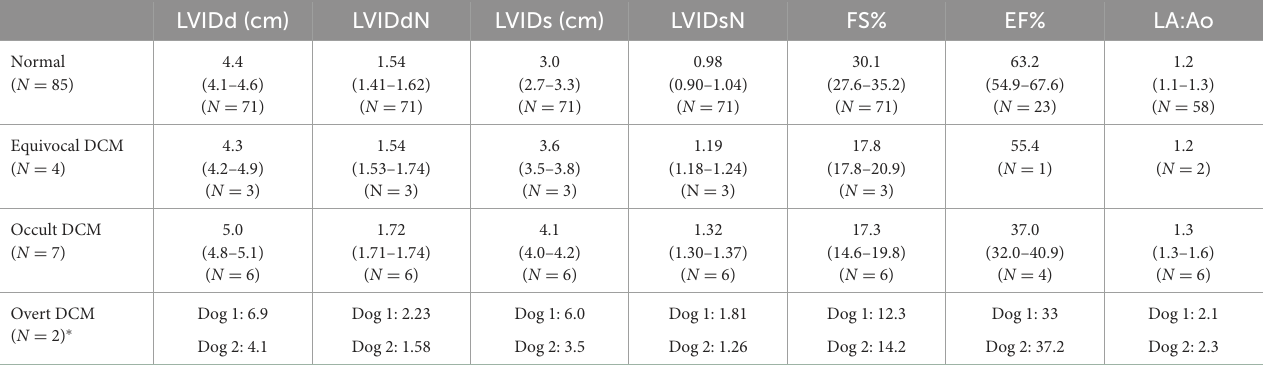
TABLE 3 Select echocardiographic measurements from structurally normal Borzoi and Borzoi diagnosed with equivocal, occult, and overt dilated